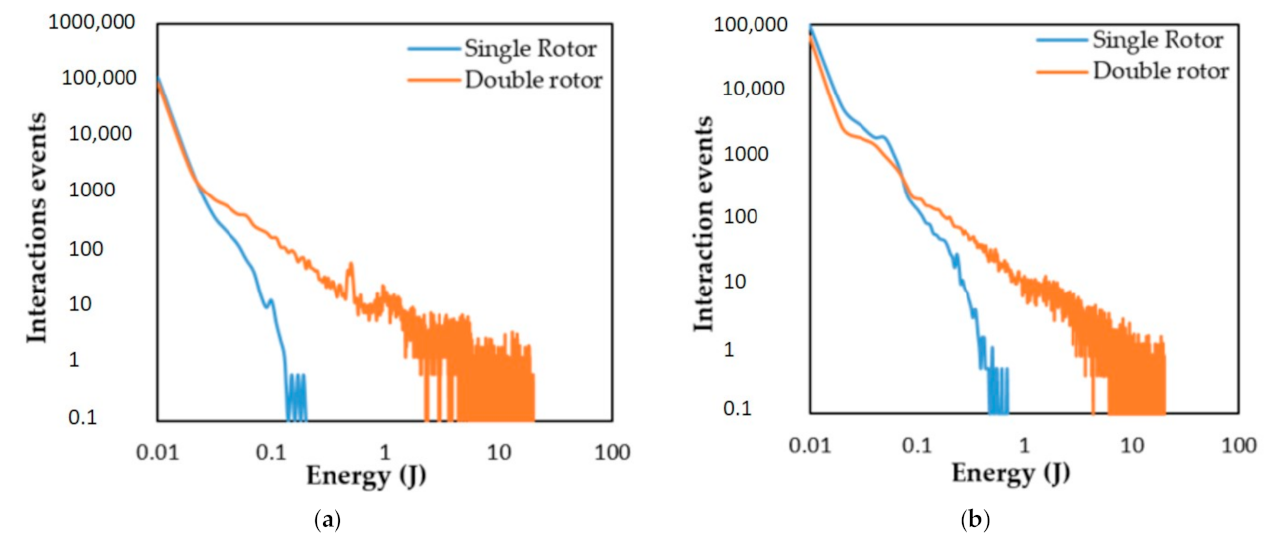
Figure 5. Energy spectra Comparison for single and double rotor for 13.2 + 11.2 mm particles; ( a ) at 1040 rpm and ( b ) at 2080